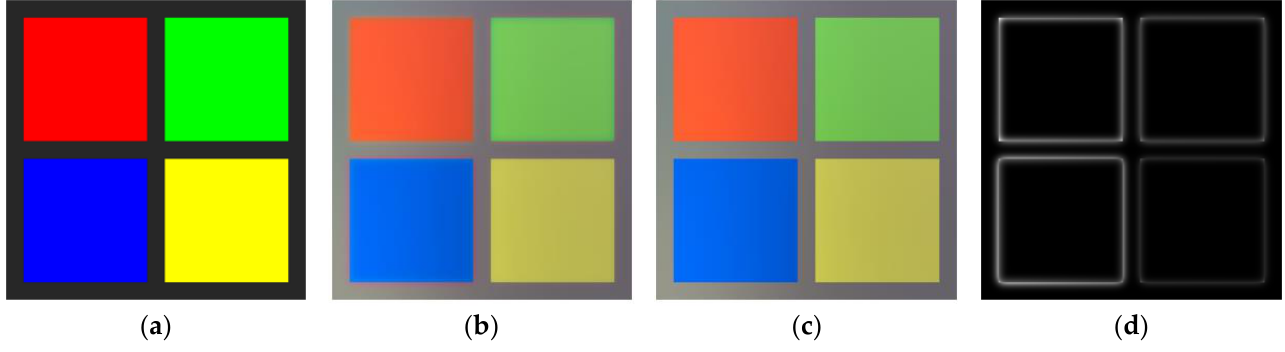
Figure 3. Color difference map; ( a ) input image; ( b ) tone-compressed base layer image; ( c ) tone- compressed original layer image; ( d ) color difference map.